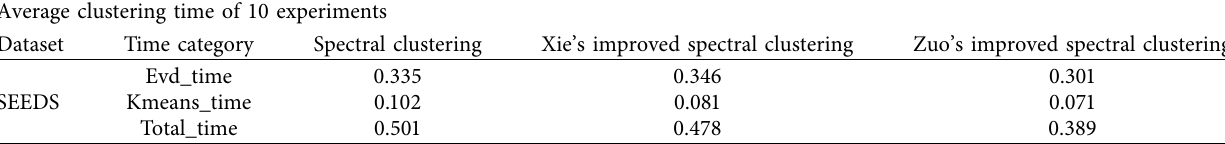
Table 2: Clustering time of the SEEDS dataset.